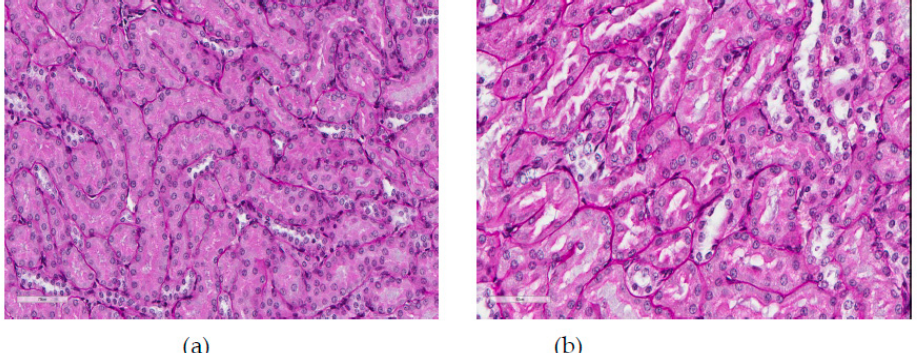
Figure 7. ( a ) Kidney of a control rat (proximal convoluted tubules with an intact brush border). ( b ) Kidney of a rat exposed to NiO-NP inhalation during 10 months (marked degenerative and necrobiotic changes in tubular epithelial cells up to their disappearance; partial destruction of the brush border). Periodic acid–Schiff (PAS) stain; magnification: 400×.